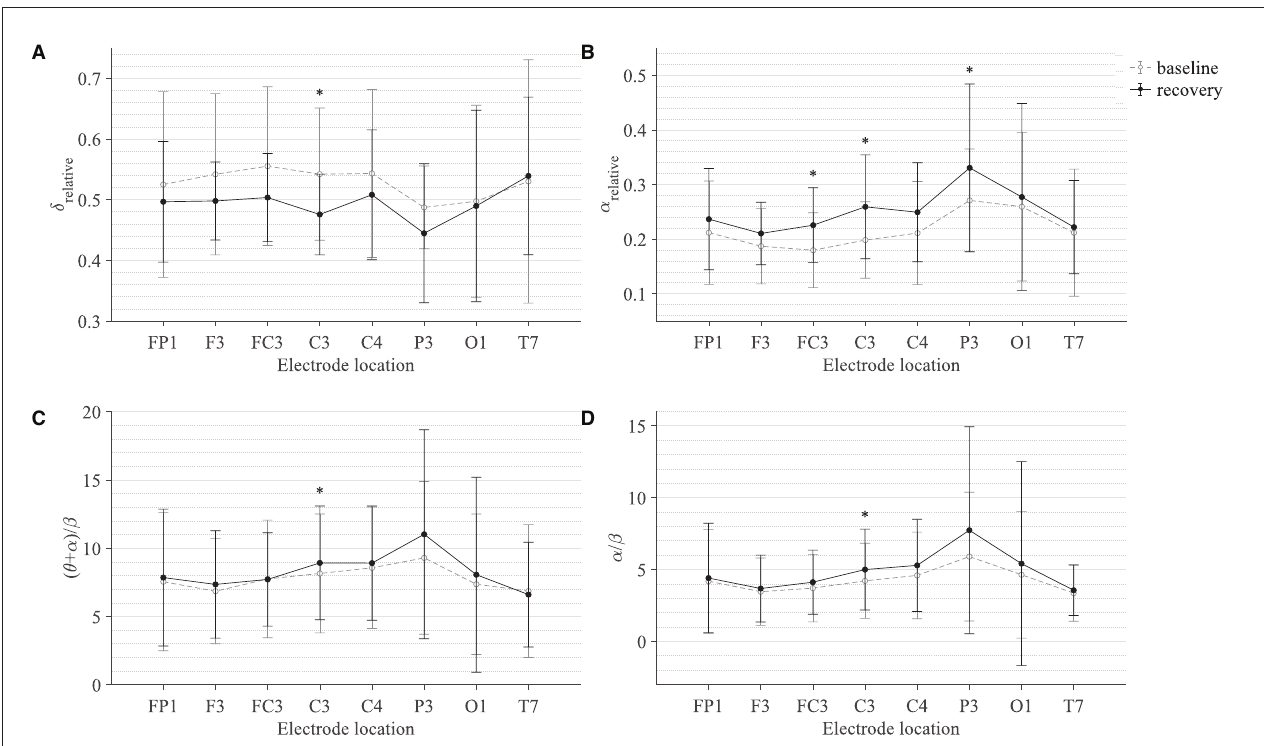
FIGURE 6 | Comparison of the sample mean and standard deviation of (A) δ relative , (B) α relative , (C) ( θ + α ) /β , and (D) α/β of all participants between baseline and recovery states for the gross motor interaction with HapticMASTER. The statistical significance is represented by an asterisk: i.e., *p < 0.05.